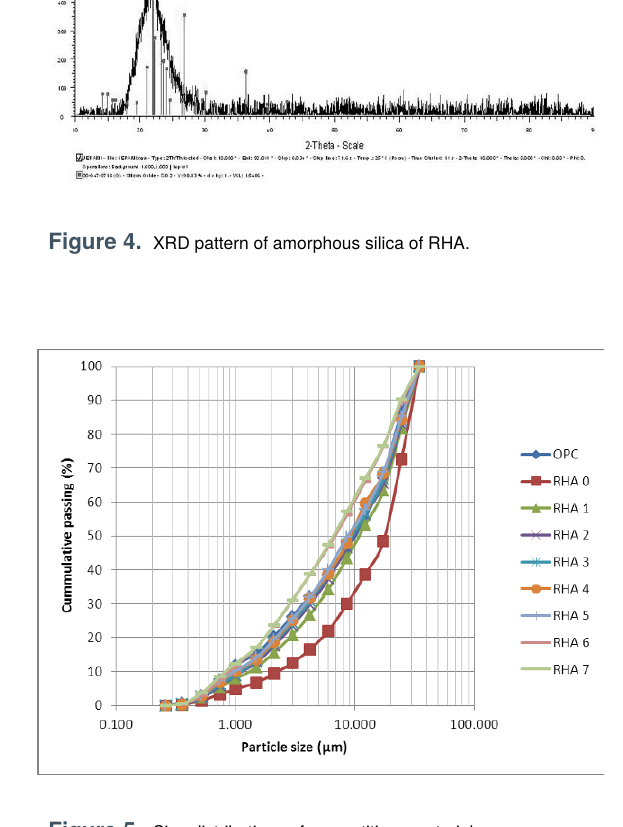
Figure 5. Size distributions of cementitious materials.